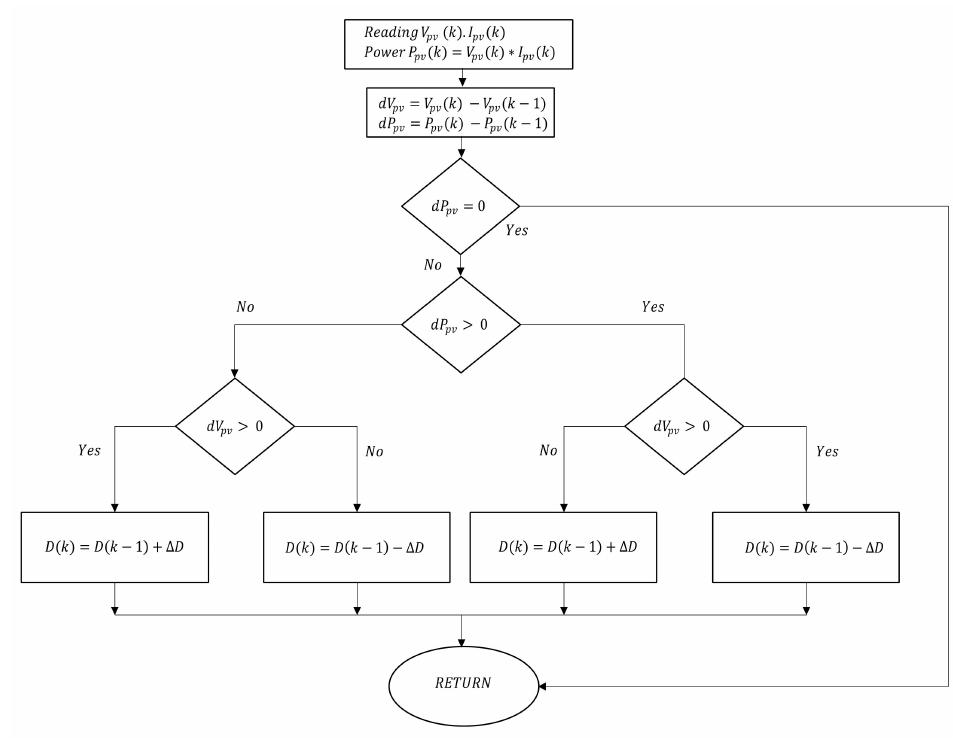
Figure 5. Flow chart for PV